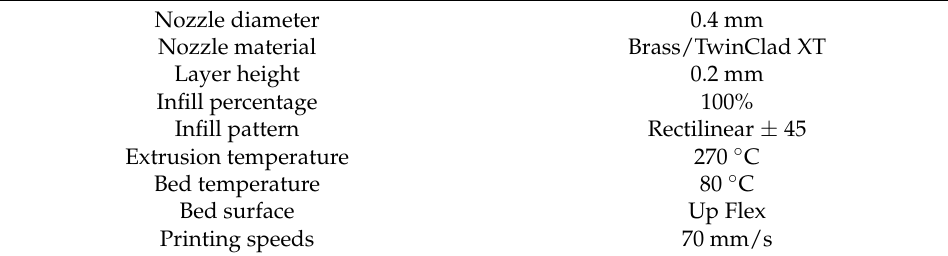
Figure 3. Samples obtained by the method of: ( a ) 3D printing; ( b ) injection molding. The process parameters are summarized in Tables 2 and 3. Table 2. Selected printing parameters.